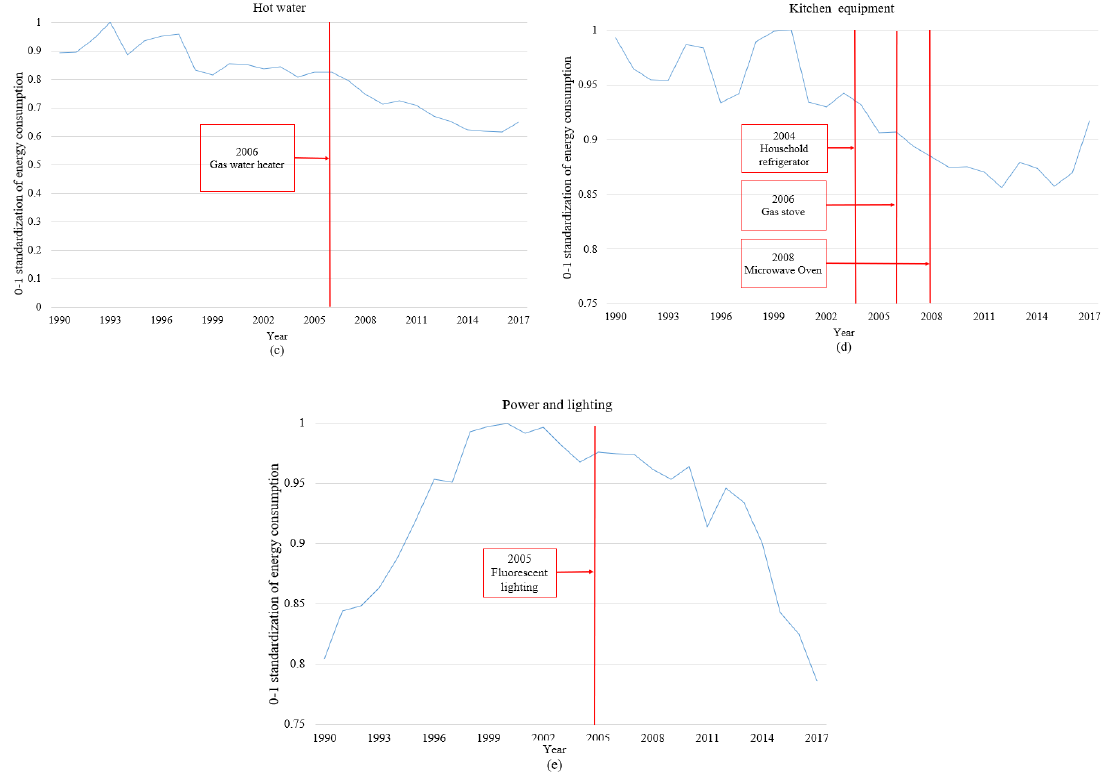
Figure 7. Comparison of different types of energy consumption and the starting time of corresponding policies in tertiary industry (( a ) Refrigeration; ( b ) Hot water; ( c ) Heating; ( d ) Kitchen equipment; ( e ) Power and lighting).